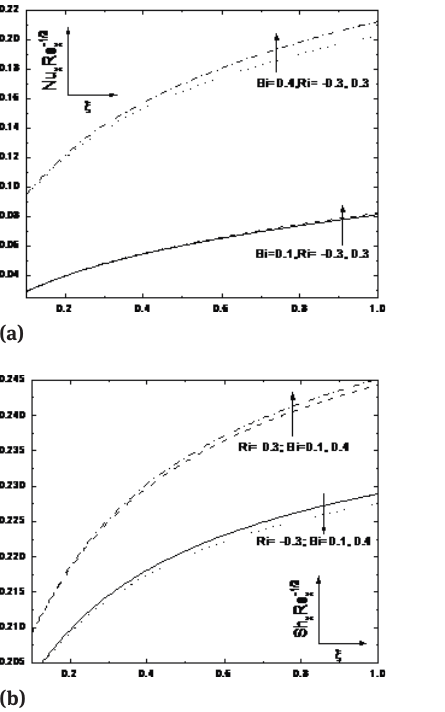
Fig. 9: The influence of angle of inclination on (a) heat transfer rate, (b) mass transfer rate for a fixed values of Δ = 0.5, Fs = 0.5, α 1 = 5, α 2 = 5, Bi = 0.5. .